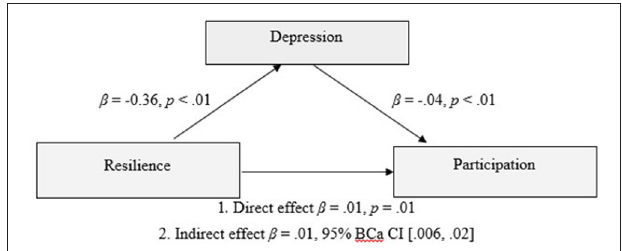
FIGURE 1 | Model of resilience as a predictor of participation outcomes, mediated by depression scores of the participant.